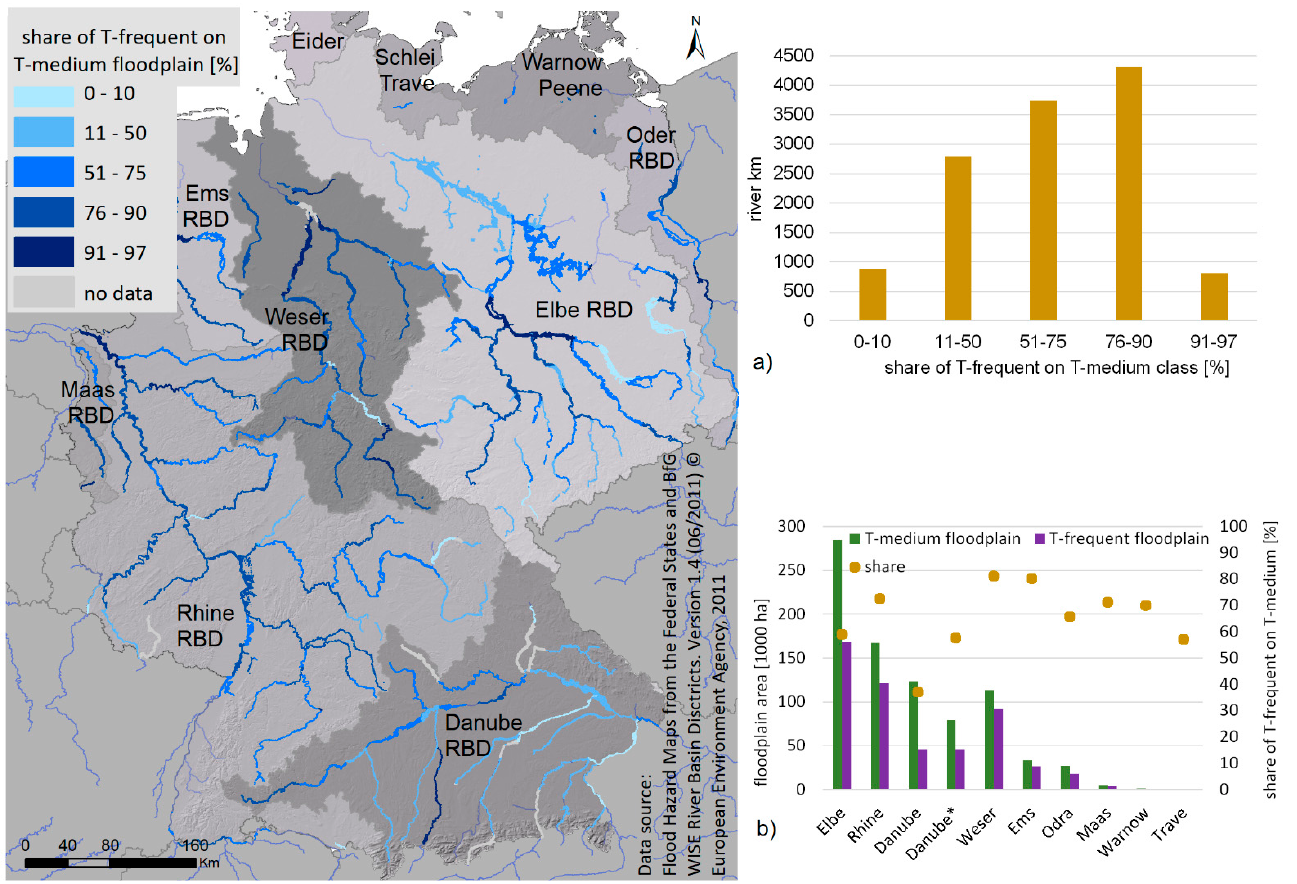
Figure 5. Comparison of T–medium and T-frequent areas, T–frequent area as % of T–medium. ( a ) Comparison on the basis of river basin districts. Danube * is an adapted calculation for the T-medium due to missing T–frequent results for 700 km of selected rivers in Bavaria. ( b ) Comparison with river length based on the hydrological units.